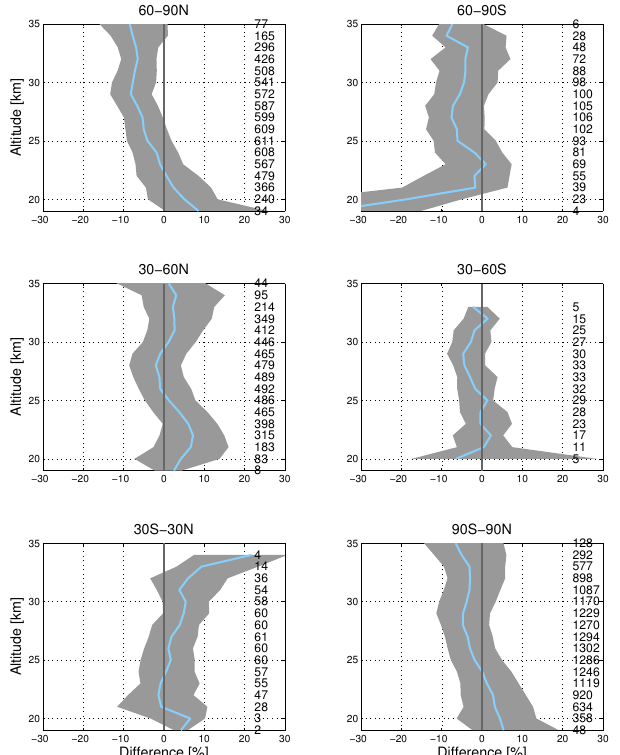
Figure 7. Interquartile ranges (shaded areas) and medians (solid lines) of the individual relative differences of GBL ozone profiles against NDACC ozonesondes for different latitude zones. The num- bers are the amount of co-located points at each altitude.